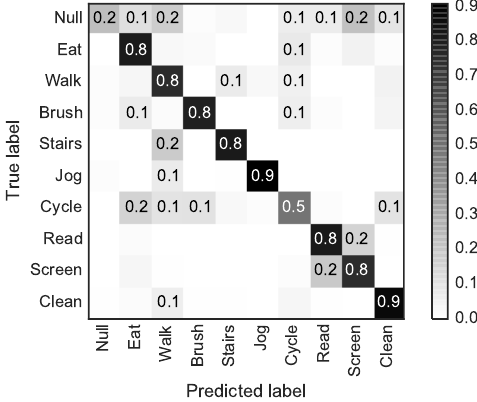
Figure 5: Daily activity recognition: confusion ma- trix across cross-validation folds. With the excep- tion “cycle” cluster, all activity cluster perform at an accuracy of at least 80 %. Null class performance was low due to the nature of the study